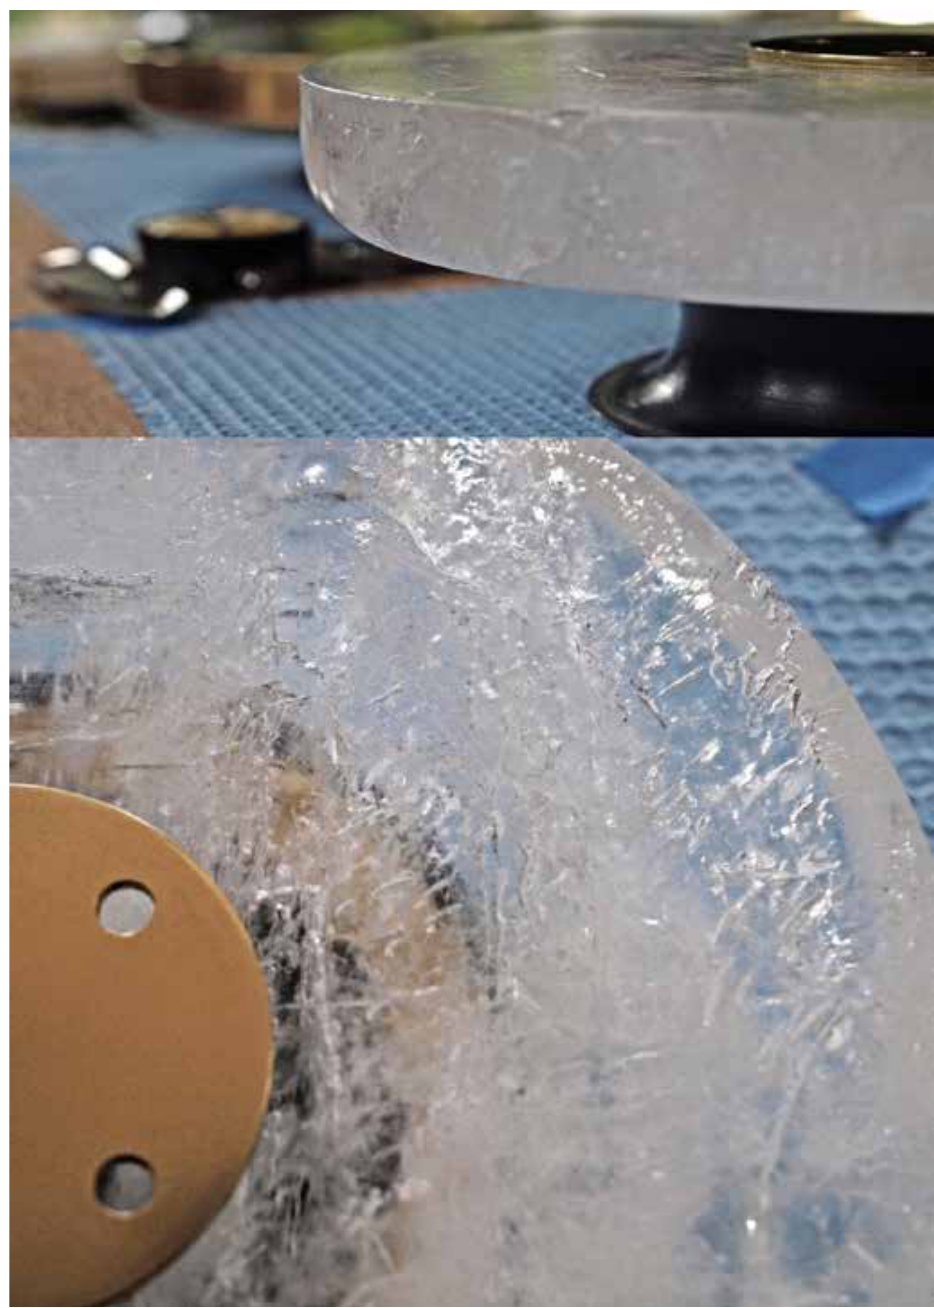
Figure 11: Traces of wear. Brass and acetal thermoplastic details on a crystal potassium alum door handle. Subjected to use, the crystal erodes over time revealing the pattern of use whilst fulfilling a simple sanitation role in the process. Source: